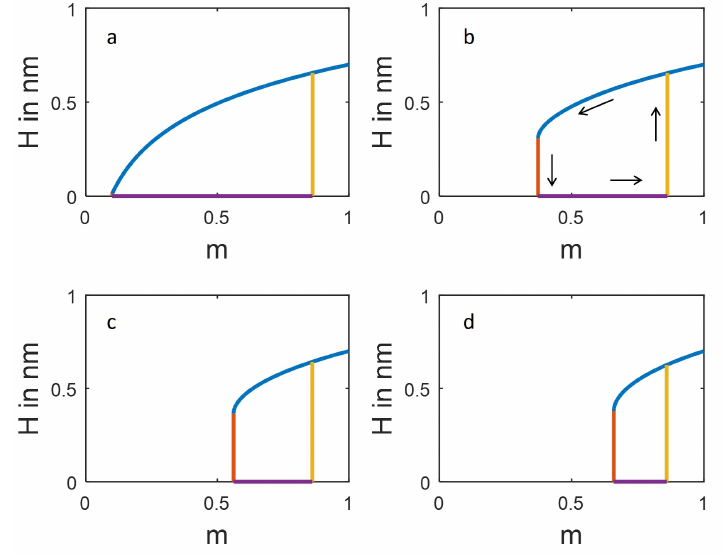
Figure 4. Thickness of a circular slit filled with water ( H 0 = 0.7 nm, R = 5 nm) embedded in a soft solid ( E = 5 GPa, ν = 0.33, w = 0.1 N/m, q = 1, T = 300 K) evaluated by using Equation (15). The interaction length ξ is different: ( a ) ξ = 0.001 nm, ( b ) ξ = 0.1 nm, ( c ) ξ = 0.2 nm and ( d ) ξ = 0.3